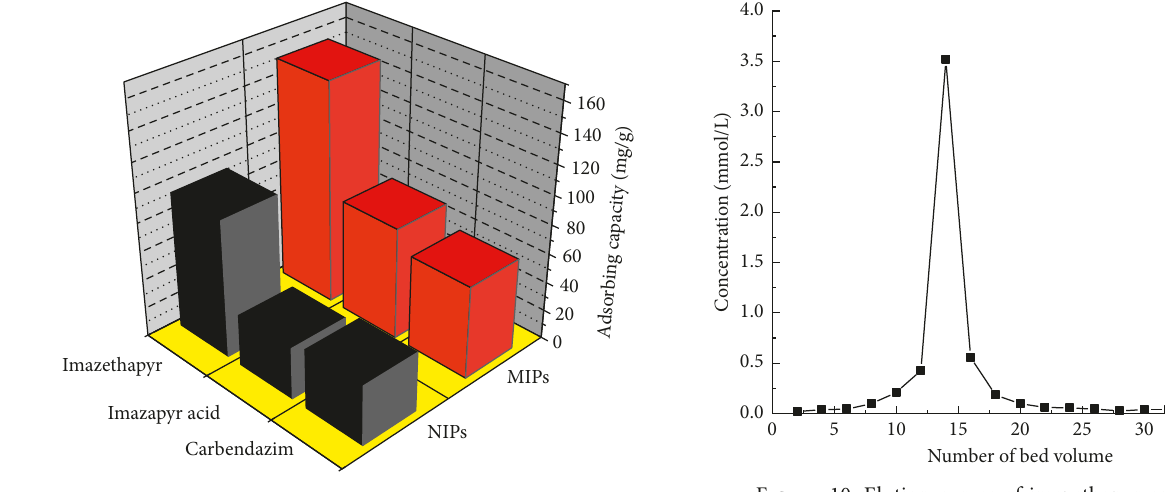
Figure 10: Elution curves of imazethapyr on Table 2: Recoveries of imazethapyr in soil samples. Figure 9: Selective adsorptions for the imazethapyr, imazapyr, and